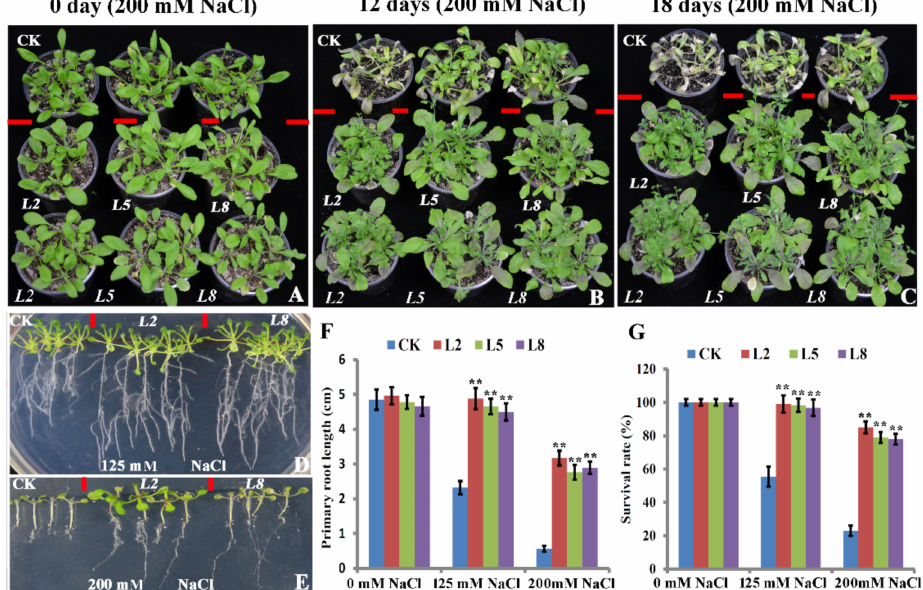
Figure 2. Phenotypes of transgenic Arabidopsis plants overexpressing bolTLP1 under salt stress. ( A – C ): Phenotypes of 35S:: bolTLP1 Arabidopsis at 0 day, 12 days and 18 days after irrigated with 200 mM NaCl in nutrient soil, respectively. ( D , E ): Phenotypes of 35S:: bolTLP1 Arabidopsis seedlings at 15 days after growing in 1/2 MS medium with 125 mM and 200 mM NaCl, respectively. ( F ): Primary root length of 35S: :bolTLP1 Arabidopsis at 15 days after growing in 1/2 MS medium with 125 mM and 200 mM NaCl. ( G ): Survival rates of 35S:: bolTLP1 Arabidopsis at 18 days after irrigated with 125 mM and 200 mM NaCl in nutrient soil. (Student’s t -test, ** p < 0.01; data are means ± SD ( n ≥ 15)). The top row of ( A – C ) showed the vector controls (CK), and the middle and bottom rows showed the independent 35S:: bolTLP1 Arabidopsis lines ( L2 , L5 and L8